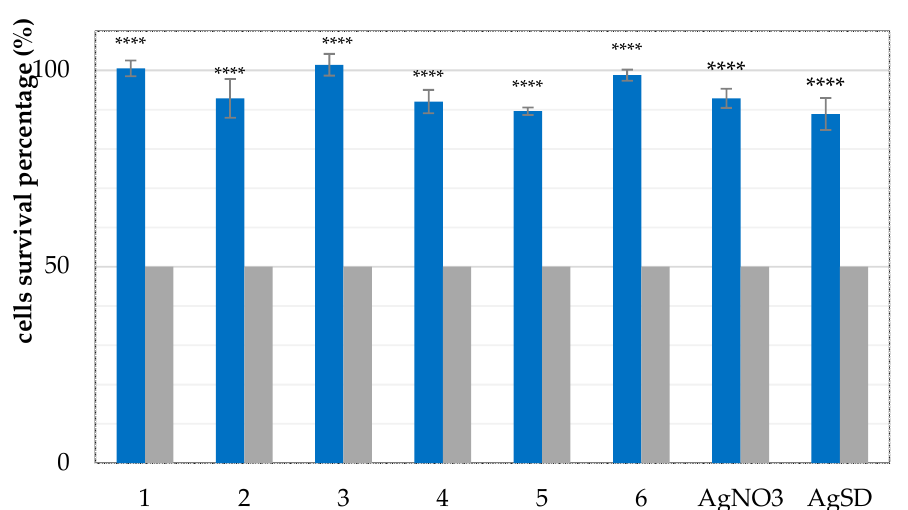
Figure 6. Percentage of survival 10T1/2 cells treated with complexes 1 – 6 , AgNO 3 and AgSD, in concentrations that correspond with IC 50 values for B16 cells. Statistical analyses were done using GraphPad Prism 6 and one-way ANOVA with Bonferroni’s multiple comparisons test. p < 0.05 was considered as statistically significant one. Data were showed as mean with SD of three independent experiments. **** p < 0.0001